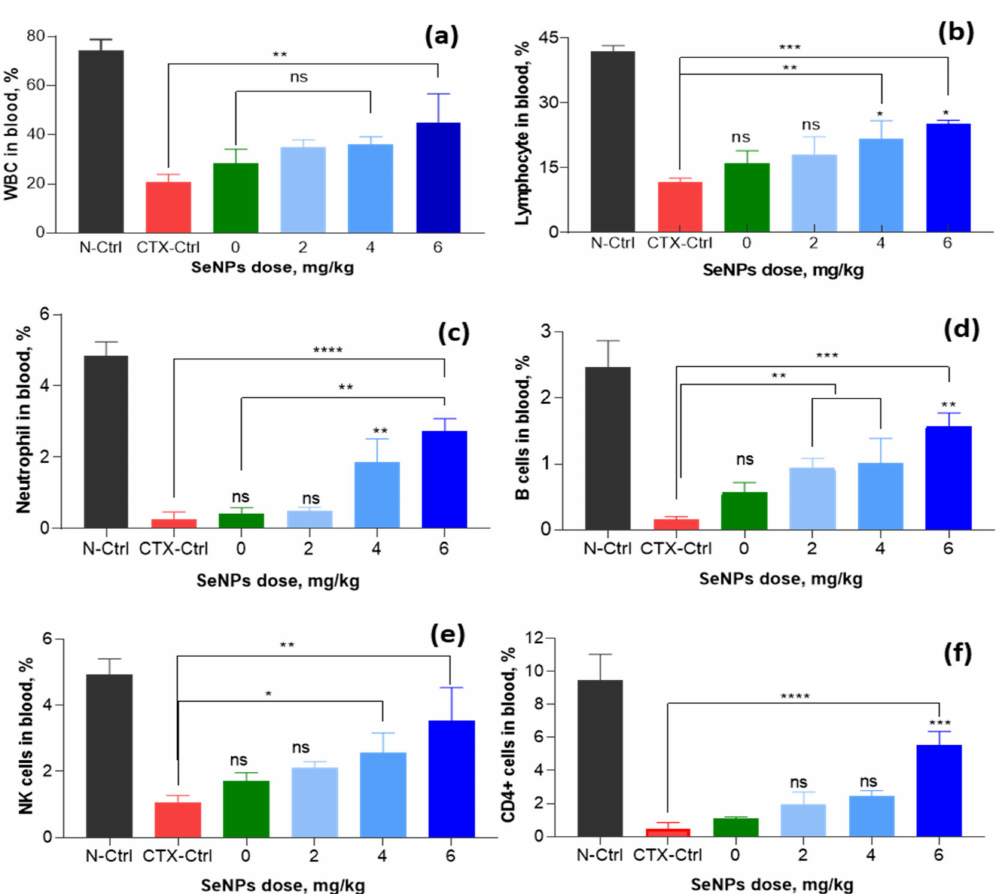
Figure 11. Effect of SeNPs/ β -glucan concentration on cellular immunity indexes in peripheral bloods of CTX-induced immunosuppressed mice. ( a – f ) are WBCs, lymphocytes, neutrophils, B cells, NK cells and CD4+ cells, respectively; N-Ctrl: Normal control mice received only distilled water; CTX-Ctrl: CTX-induced immunosuppressive mice received only distilled water; in supplemented groups, mice were orally supplied with 0 (only β -glucan without SeNPs), 2, 4 and 6 mg SeNPs kg − 1 . Significant differences were compared with the CTX-Ctrl. ns, not significantly different at p > 0.05; *, significant different at p < 0.05; **, significant different at p = 0.01, *** significant different at p < 0.01; ****, significant different at p < 0.001. Data were statistically analyzed using the ANOVA test and expressed as means ± SD, n =